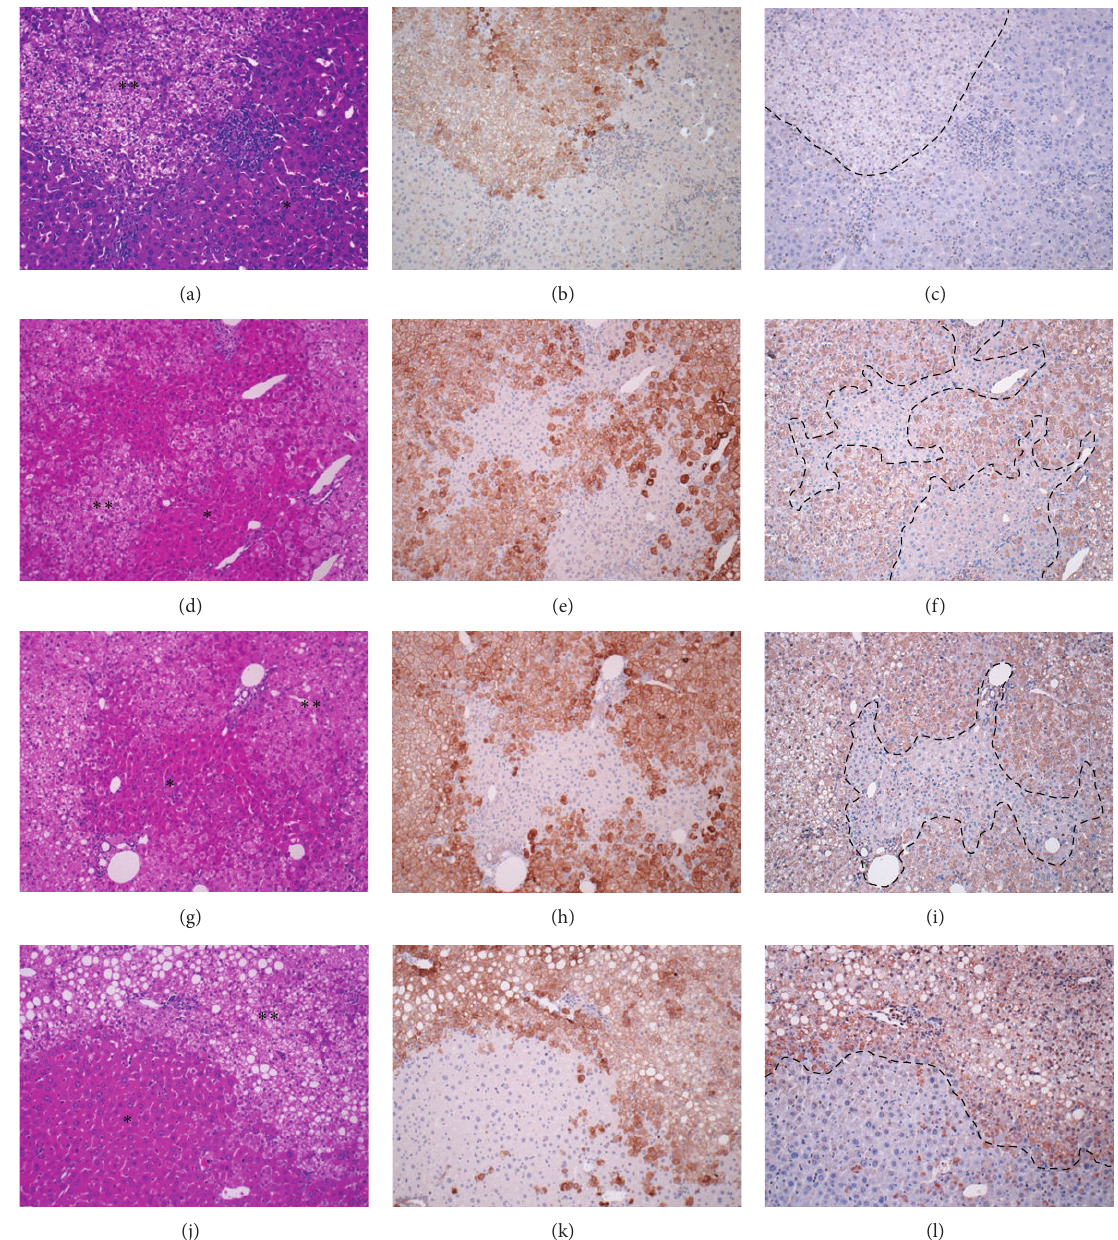
Figure 1: HCV-RNA localization with LNA-based ISH in the liver of chimeric mice infected with HCV of different genotypes. (a)–(c) HCV noninfected, (d)–(f) HCV genotype 1a-infected, (g)–(i) HCV genotype 1b-infected, (j)–(l) HCV genotype 2a-infected, ((a), (d), (g), (j)) HE stain,((b),(e),(h),(k))immunostainingforhuman-specificCK8/18,((c),(f),(i),(l))LNA-basedISH,( ∗ )mousehepatocytes,and( ∗∗ )human hepatocytes. HCV-RNA is demonstrated diffusely in the cytoplasm of human hepatocytes in the chimeric livers. No signals are seen in the noninfected